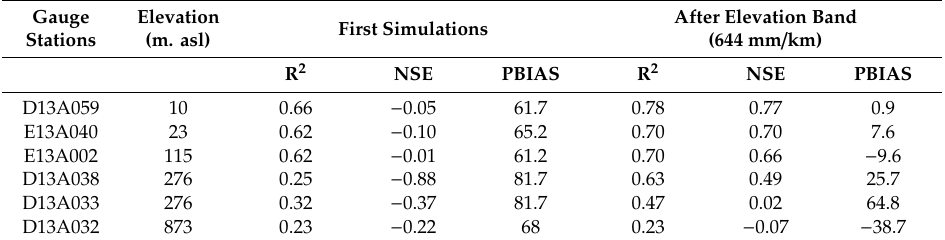
Table 4. Model performance improvement on uncalibrated SWAT simulations by the application of elevation bands (including full-time period for each gauge stations) to the local climate datasets. R 2 Coefficient of determination NSE: Nash–Sutcliffe efficiency, PBIAS : Percent bias.